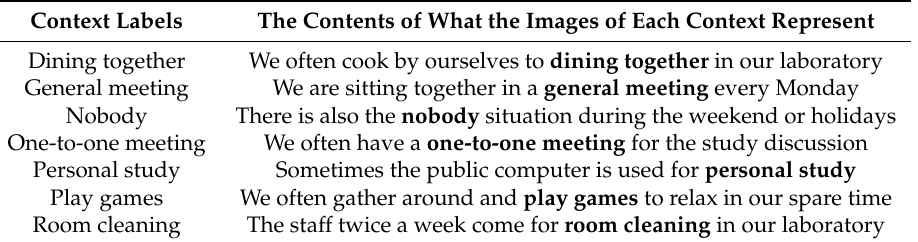
Table 1. The detail of each defined context in this